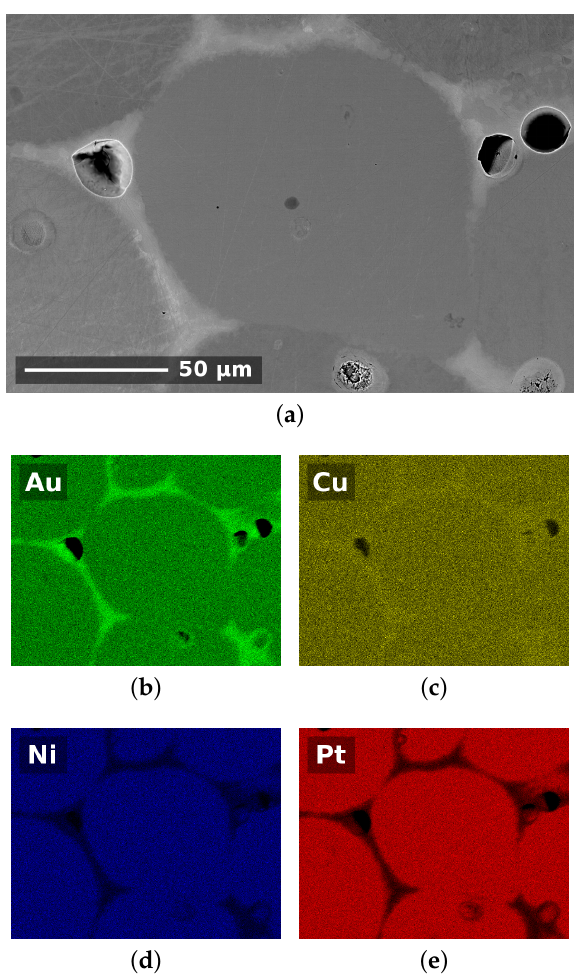
Figure 5. Microstructure ( a ) as obtained from scanning electron microscopy utilizing backscatter electron imaging of AuCuNiPt in the highly segregated state as well as elemental mappings obtained from energy dispersive X-ray analysis ( b – e